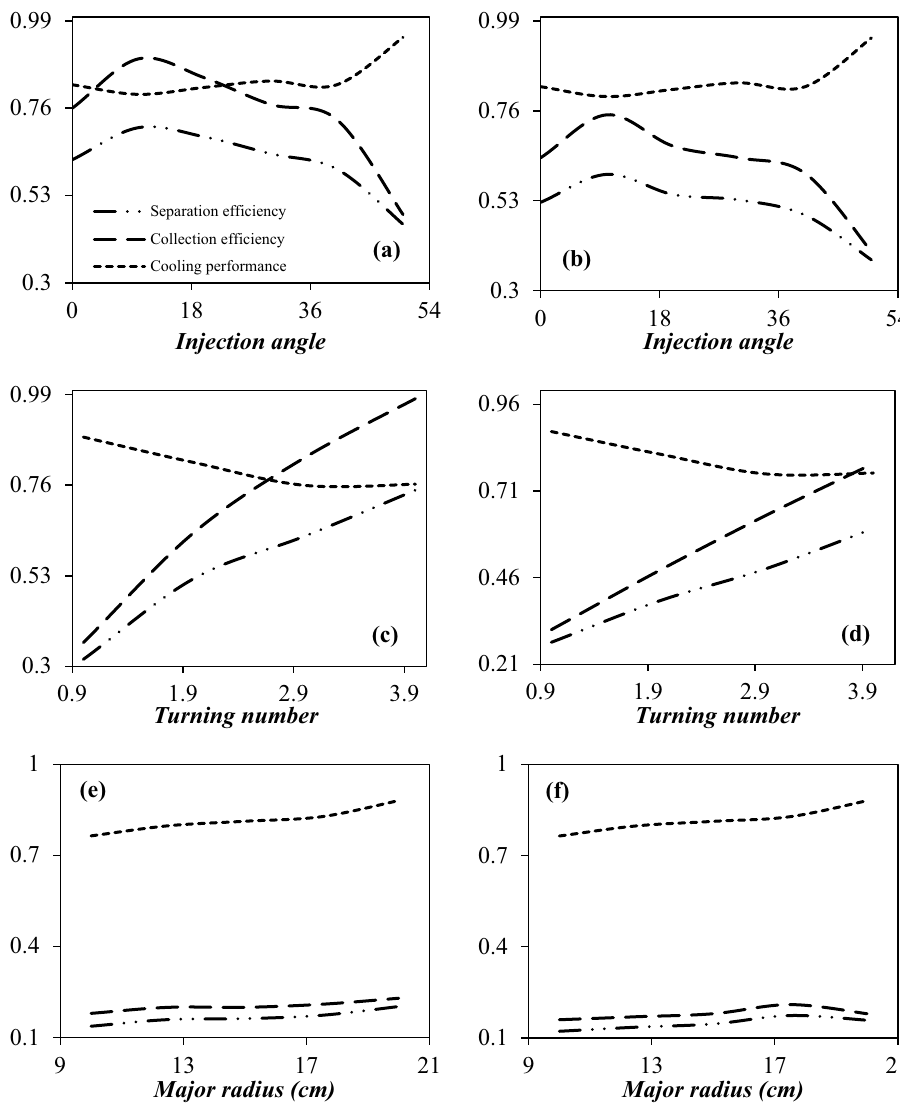
Figure 8. The influence of structural parameters on the collection efficiency, cooling performance and separation efficiency of 3S quipped with side injected swirler ( a , b ), serpentine swirler ( c , d ) and U-turn swirler ( e , f ) for water ( a , c , e ) and hydrocarbon droplets ( b , d , f